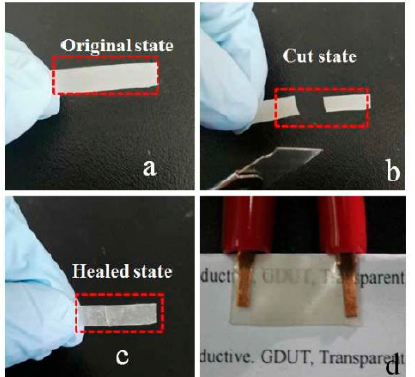
Figure 13. Illustration of healing process in epoxy/PCL blend mixed with silver nanowires: ( a ) original state, ( b ) after inducing cut; ( c ) after inducing electrical self-healing. ( d ) The composite turns transparent after healing in an oven [109]. Reproduced with permission from Luo, H; Pigment & Resin Technology; published by Esmerald Publishing, 2018.